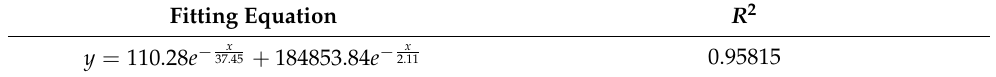
Table 4. Curve fitting results.